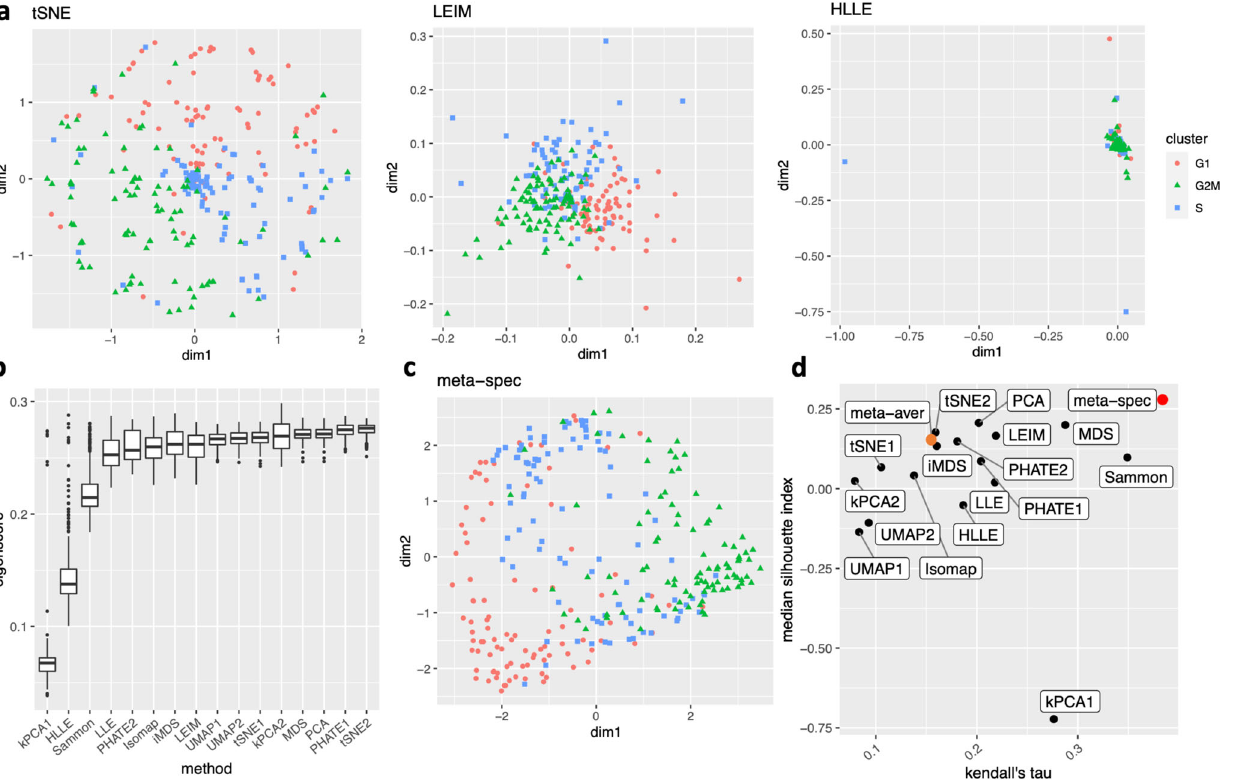
Fig.4|Visualizationofthecellcycleof288mouseemryonicstemcells.a Three examples of candidate visualizations. The cells are marked by three different symbols and colors according to their associated cell cycle stages. More examples are included in Supplementary Fig. 16. b Boxplots (center line, median; box limits, upper and lower quartiles; points, outliers) of eigenscores for all 16 candidate visualizations,eachcontaining n =288samples. c Theproposedmeta-visualization